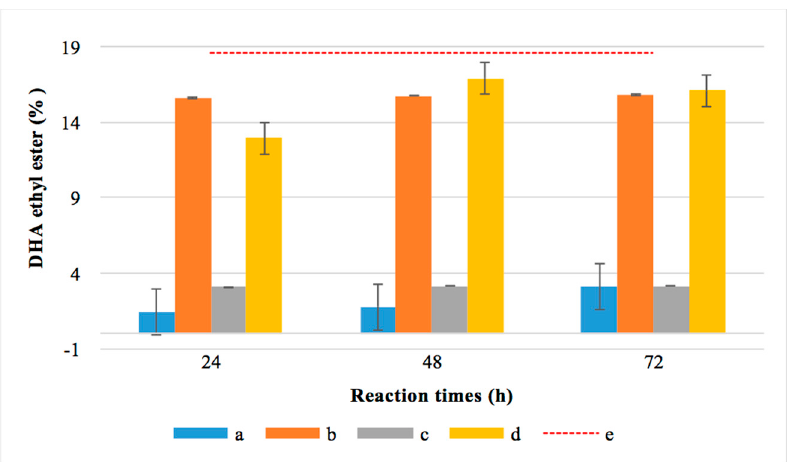
Figure 7. Percentage of docosahexaenoic acid (DHA) before and after total chemical esterification for 24, 48 and 72 h using R. oryzae lipase and chemical catalysis. ( a ) Blue color: ester obtained before chemical catalysis from one-step esterification with R. oryzae . ( b ) Orange color: ester obtained after applying chemical catalysis to the crude resulting from one-step transesterification. ( c ) Grey color: ester obtained before catalysis from two-step esterification. ( d ) Yellow color: ester obtained after applying chemical catalysis to the crude resulting from the two-step esterification. ( e ) Red dotted line: total DHA content in the MLO.